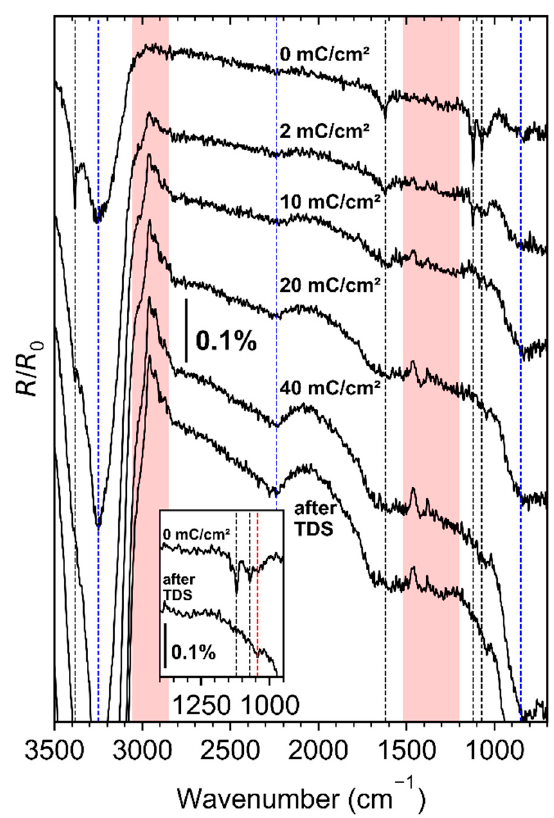
Figure 5. RAIR spectra collected for a pristine NH 3 multilayer (0 mC / cm 2 ) condensed on top of a deposit fabricated by electron irradiation ( E 0 = 31 eV, 40 mC / cm 2 ) from 7 to 10 ML (EtCp) 2 Ru on a Ta substrate held at 110 K and subsequent annealing (450 K), for the same layer with ongoing electron exposure at E 0 = 31 eV, and after post-irradiation thermal annealing to 450 K in the course of a TDS run. The dashed blue vertical lines correspond to H 2 O vibrations due to water ice frozen onto the detector window [35], the dashed black lines correspond to NH 3 vibrations, and the red areas to changes correlating to the model deposit. A RAIR spectrum acquired just before NH 3 dosing served as a background for all spectra shown here. Inset: Enlarged view of the RAIR spectra at 0 mC / cm 2 and after TDS for the spectral range 1000–1200 cm 2 . The dashed red line marks the position of the CN stretch of gaseous methylamine at 1044 cm − 1 [36]. The CN stretch of methylamine in Kr solution is blueshifted by only 3 cm − 1 [37].